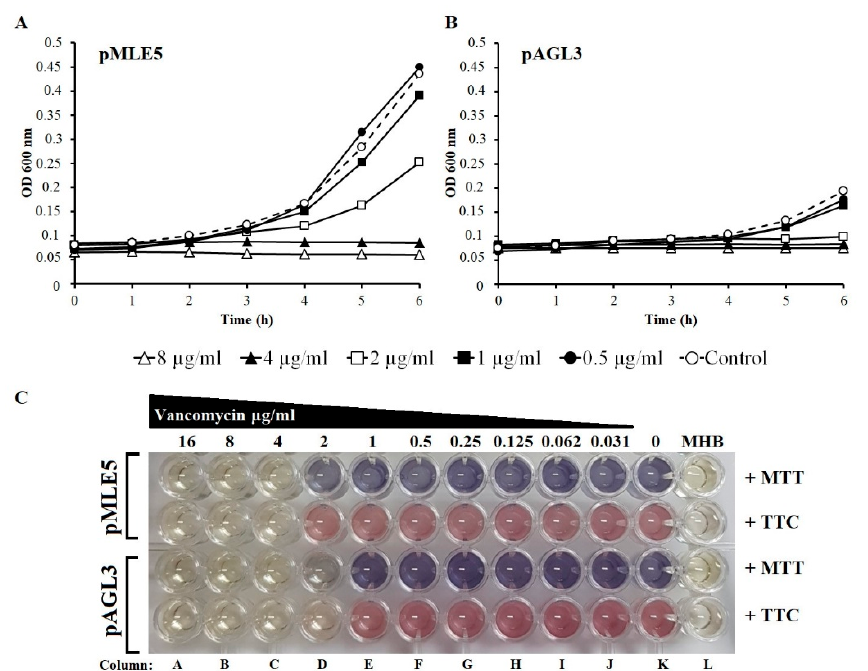
Figure 7. Influence of intracellular Tgl protein on susceptibility of S. aureus to vancomycin. ( A ) Growth of Tgl producing S. aureus RN4220 cells in the presence of vancomycin at various concentrations. Overnight cultures of S. aureus cells bearing pAGL3 ( tgl + ) or pMLE5 plasmid (empty control vector) were diluted 1:100 in Muller Hinton broth (MHB) supplemented with chloramphenicol (20 µ g / mL) and incubated with shaking for 1 h at 30 ◦ C and an additional 1 h at 42 ◦ C (to derepress the expression of cloned tgl gene). At time zero, 100 µ L portions of cultures were transferred to wells of pre-warmed (42 ◦ C) honeycomb plates containing 100 µ L MHB supplemented with vancomycin at concentrations indicated. Plates were incubated in a Bioscreen C Microbiology Plate Reader for 6 h at 42 ◦ C with medium-intensity shaking. Optical density of samples (OD 600 ) was measured during the whole experiment in 15 min intervals. Each curve shows representative result of one of three independent experiments. ( B ) Determination of minimum inhibitory concentrations (MICs) of vancomycin for S. aureus cells producing Tgl protein. MICs of vancomycin were determined in MHB using two-fold dilution plate method, as described previously [67], with some modifications. Briefly, 100 µ L portions of RN4220 cell cultures containing pAGL3 or pMLE5 (as indicated) and prepared as in ( C ) were transferred to wells (columns A–K) of prewarmed (42 ◦ C) honeycomb plates containing 100 µ L MHB with (column A–J) or without (column K) vancomycin. Column L contained 200 µ L of MHB without antibiotic as control for medium sterility. Plates were incubated for 5 h at 42 ◦ C. After incubation, 66 µ L of dimethyl thiazolyl diphenyltetrazolium bromide (MTT) (0.3 mg / mL) or triphenyl tetrazolium chloride (TTC) (0.1%) per well were added (as indicated) and plates were incubated for 90 min at 37 ◦ C with gentle shaking (110 rpm). MICs were read manually. Comparison between columns L and K shows a change of natural color of MTT and TTC diluted in MHB (respectively yellow and colorless, column L) to the reduced form (respectively violet and red, column